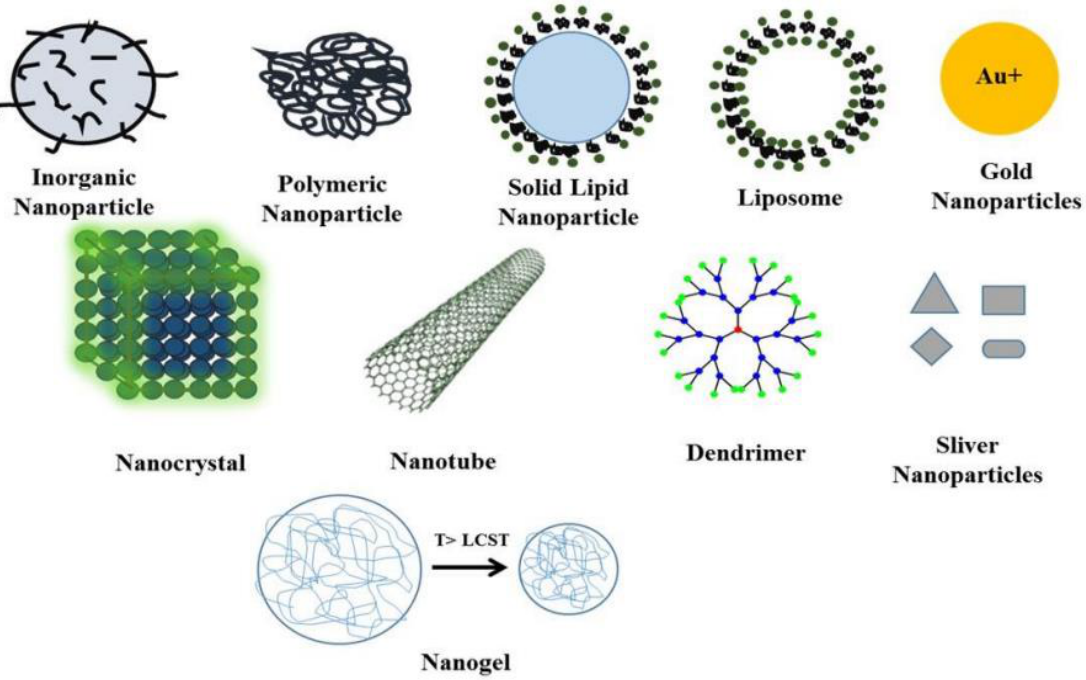
Figure 3. Various types of nanomaterials that are used in antiviral applications. Adapted with permission from ref. [34], published by MDPI, 2020.